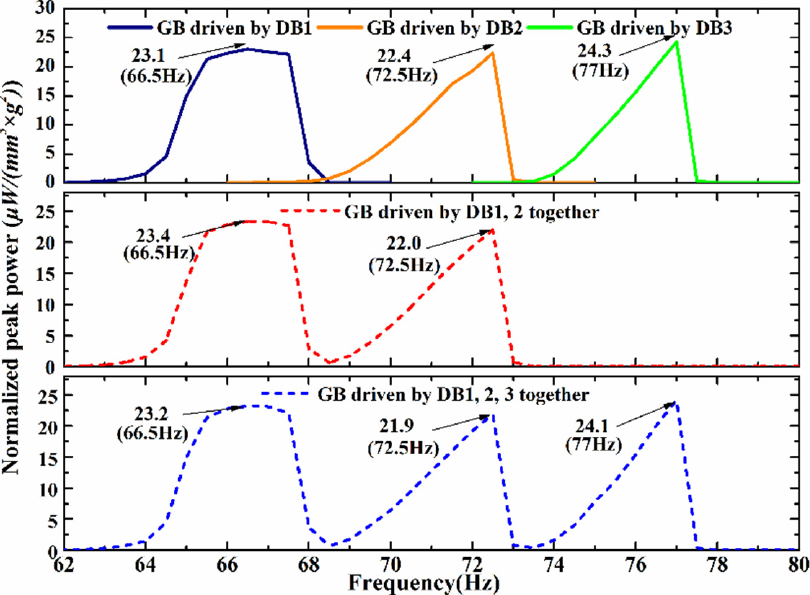
Figure 7. Normalized output power corresponding to individual and multi-LFDBs of novel VEH with optimal load resistance.